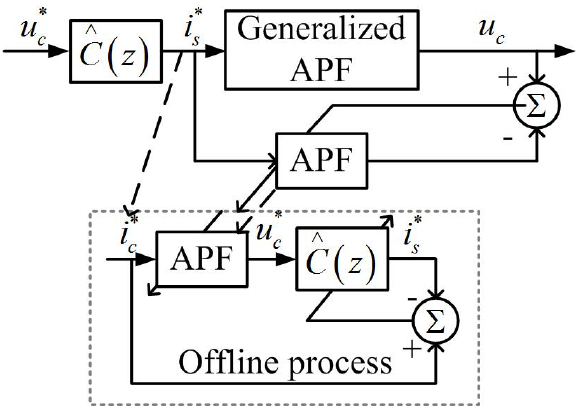
Fig. 4. Parallel APF based on adaptive inverse